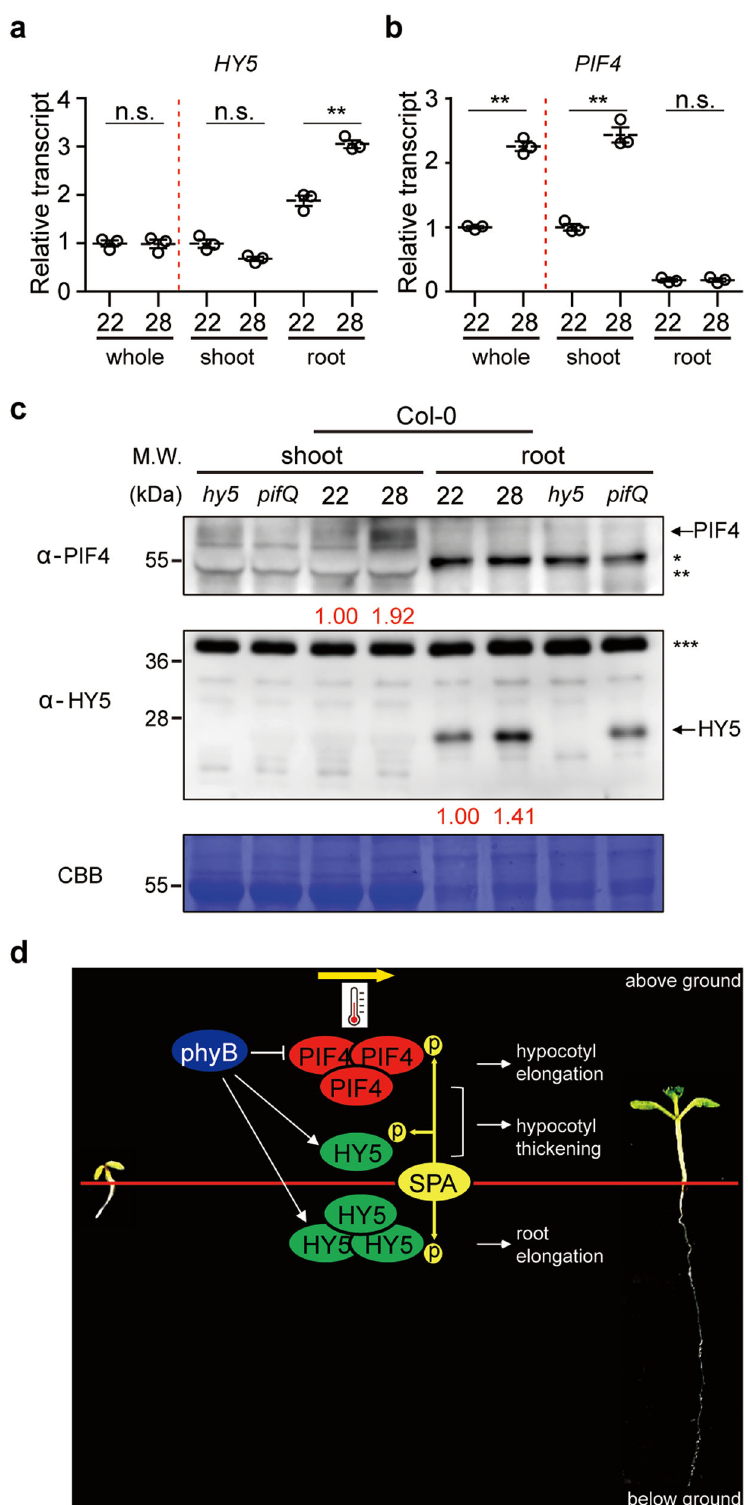
data are also consistent with the tissue-speci fi c expression and